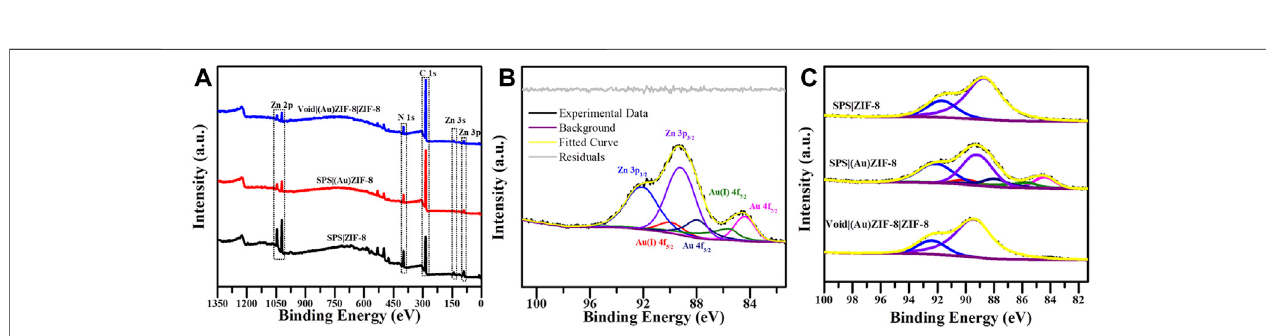
FIGURE 4 | (A) XPS wide scan spectra of SPS|ZIF-8, SPS|(Au)ZIF-8 and Void|(Au)ZIF-8|ZIF-8. (B) High-resolution XPS spectrum for Au 4f and Zn 3p of SPS|(Au) ZIF-8. (C) High-resolution XPS spectrum of SPS|ZIF-8, SPS|(Au)ZIF-8 and Void|(Au)ZIF-8|ZIF-8.